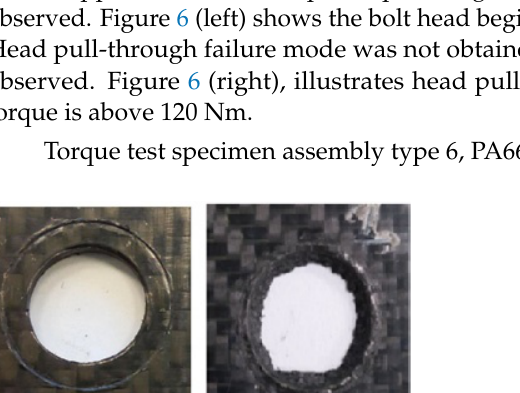
Figure 5. Specimen PA6 FG45 with washer: ( A ) Absence of crack failure after applying the maxi- mum torque. ( B ) Crack failure (Torque > maximum tightening torque).